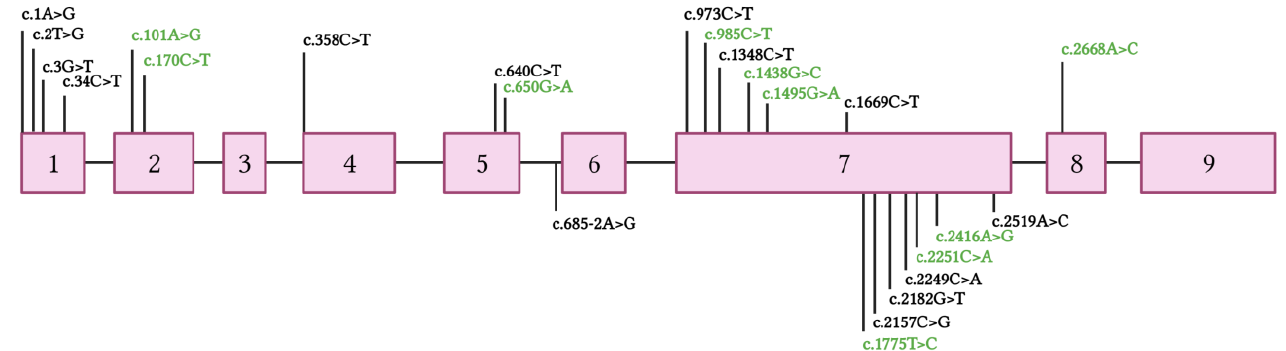
Figure 4. Point mutations classified as pathogenic and variant of uncertain significance (VUS) by the American College of Medical Genetics and Genomics (ACMG) [17] observed in ZEB1 exons up to November 2022 [18]. Variants classified as pathogenic are shown in black. Variants classified as VUS are shown in green. Any point mutation classified as “likely pathogenic” has been reported in the Leiden Open Variation Database (LOVD) [18]. The reference transcript employed is NM_030751.6.